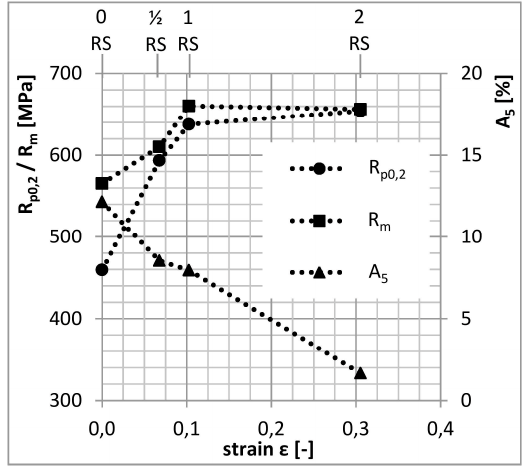
Figure 4. Peak-ageing mechanical properties vs. strain.